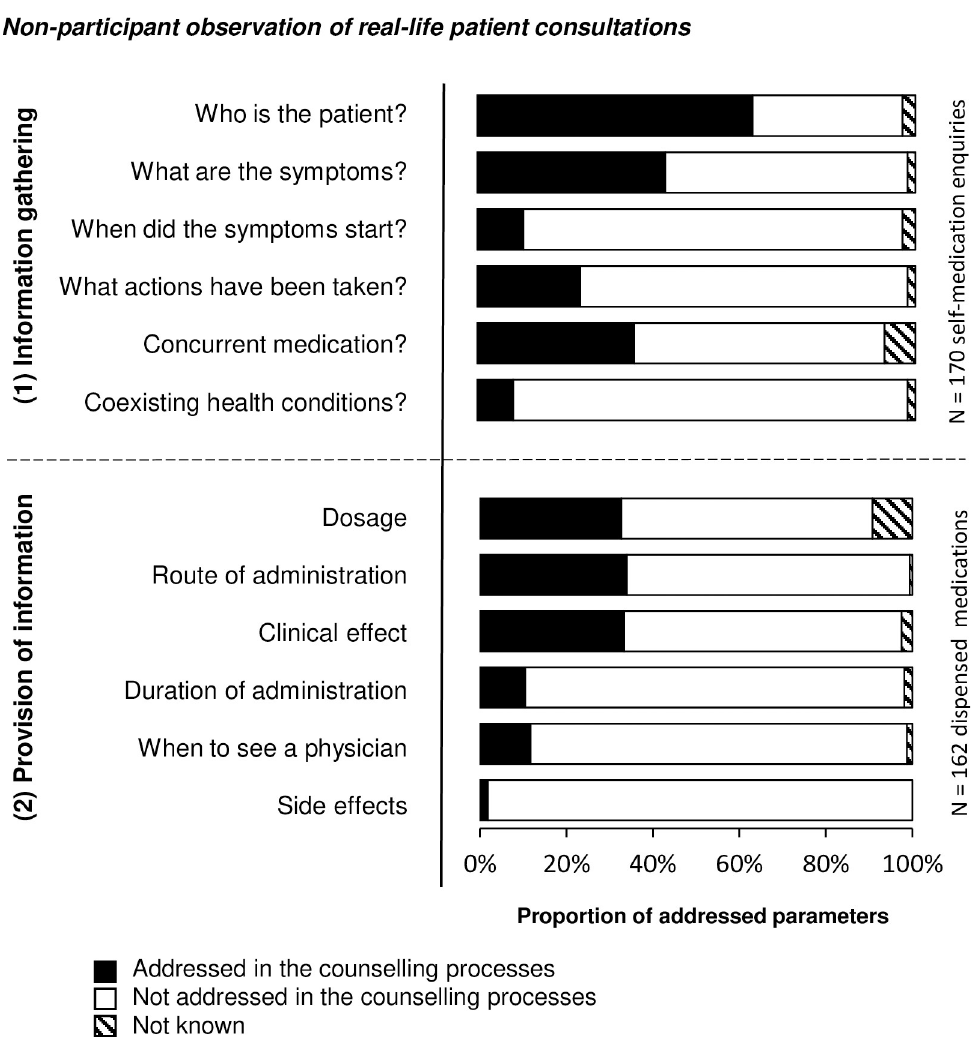
Fig 6. Observed frequency (V) of addressing the twelve parameters in the observation (study part B). 170 observed real-life self-medication enquiries were evaluated for the observed frequency (V) of addressing the parameters of information gathering (1). In 162 (100%) dispensed product processes the six parameters of information provision (2) were